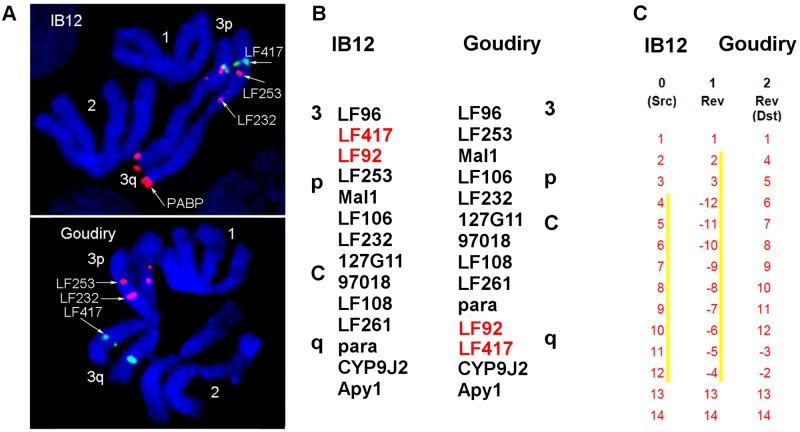
Evidence for a pericentric inversion on chromosome 3 between SenAae from Goudiry and IB12.The marker LF417 changes its chromosomal position from 3p to 3q arm in Goudiry (A). Pattern comparison of 14 markers in chromosomes between IB12 strain of Aaa and Goudiry strain (B) suggests presence of 2 large overlapping pericentric inversions in chromosome 3 or insertion on 3Q arm (C). BAC clones are named by genetic markers they are carrying.